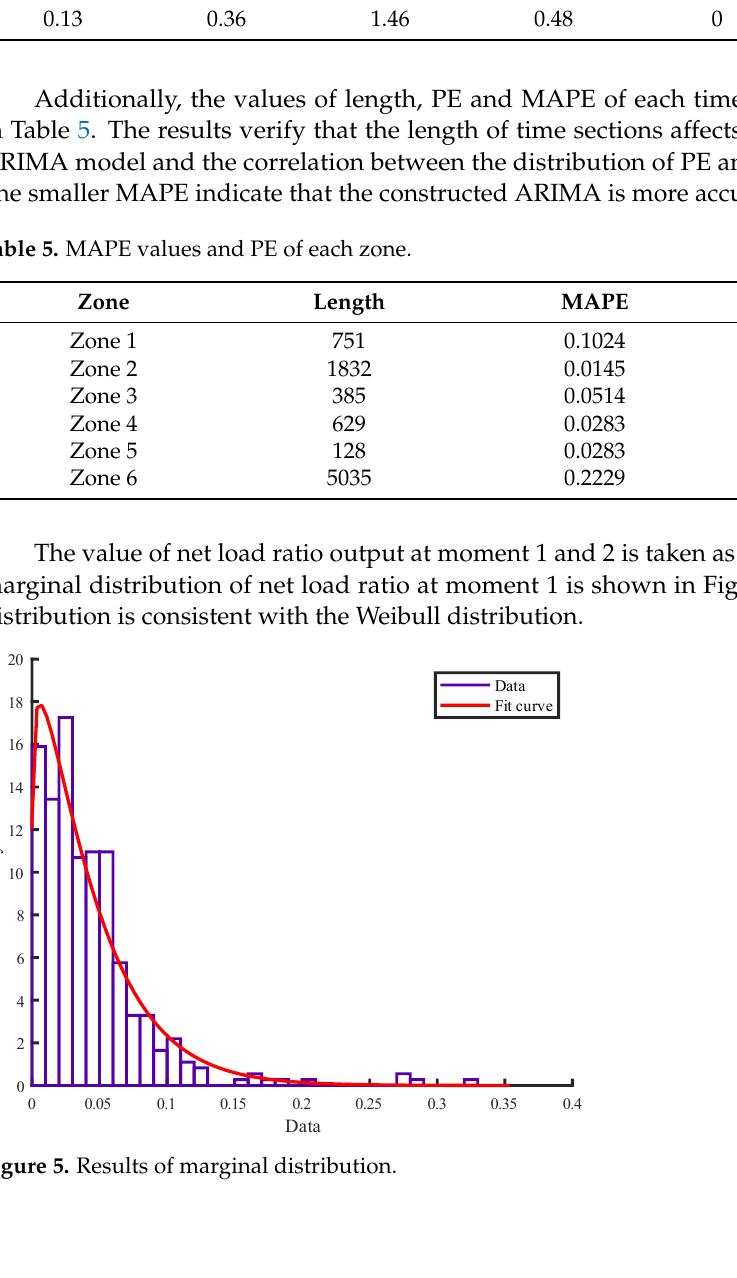
Figure 6. Results of Copula function.